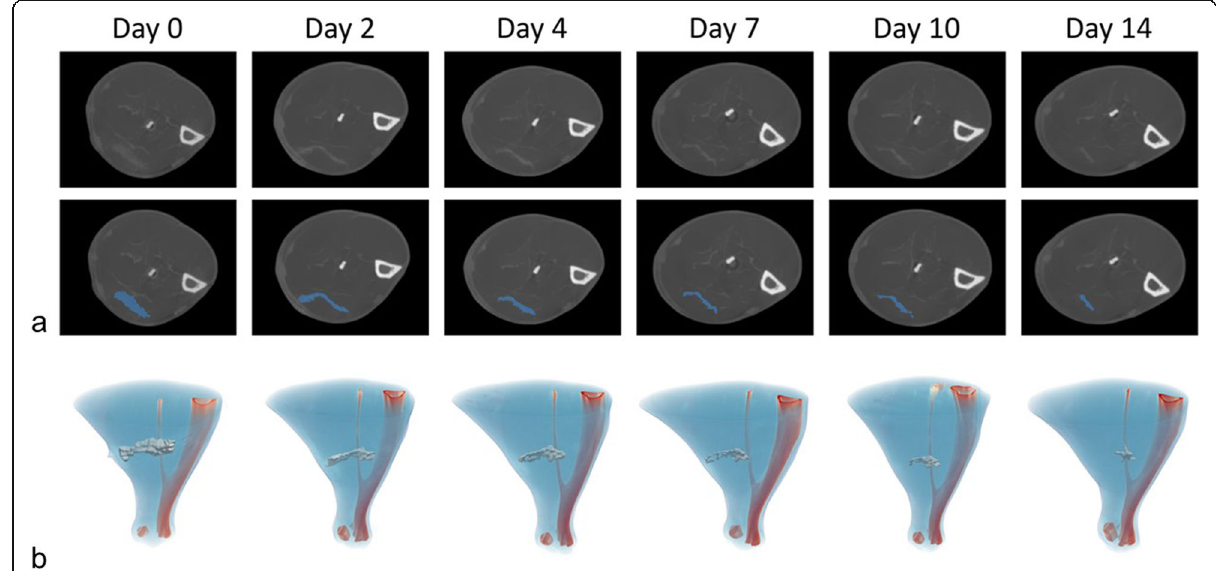
Fig. 2 Contrast-enhanced micro-computed tomography images and segmented injuries from one representative example of the validation cohort. a First row shows short-axis images of the lesion in similar location during all follow-up time points. Images were reconstructed using a filtered back-projection approach with a Ram-Lak filter. Second row images superimpose the obtained segmentation mask (blue) of the injury on the first row images. b Three-dimensional volumetric rendering of the segmented lesions (white) during all follow-up time points